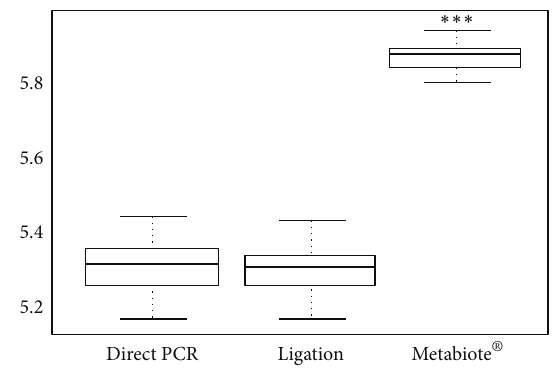
Figure 2: Shannon diversity index obtained with the three different protocols of 16S-amplicon library preparation. 𝑁 = 48 distinct indexes were used to tag a unique sample (from soil) for each of the three methods of molecular indexing. The Metabiote indexing system reveals an extended diversity reached, ∗∗∗ 𝑃 < 0.001 , and Mann-Whitney